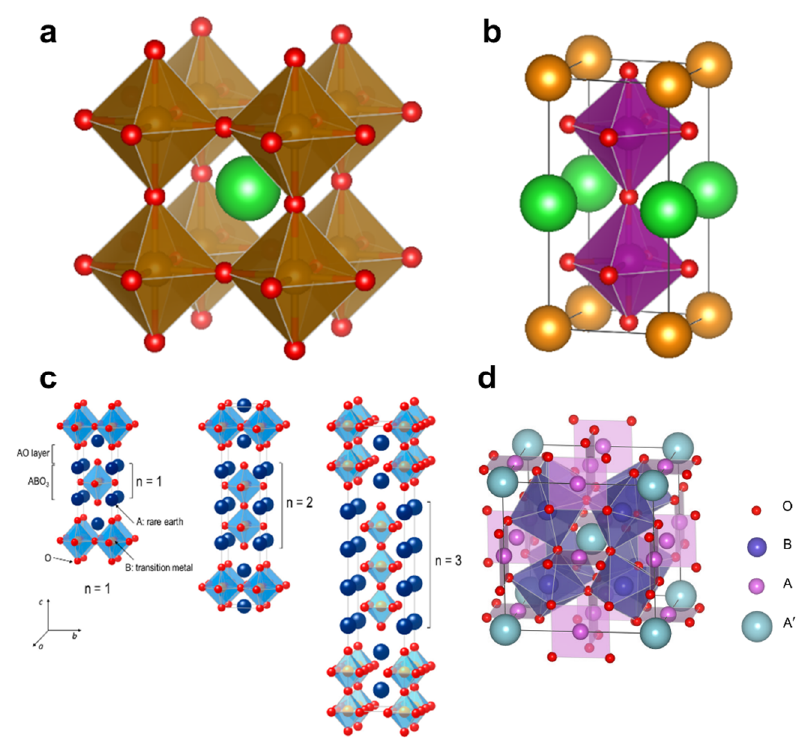
Scheme 1. Illustration of the various structures of perovskite oxides. ( a ) Primitive perovskite with an ideal cubic structure; ( b ) A-site ordered double perovskite oxide with a tetragonal structure; and ( c ) layered perovskite with a Ruddlesden–Popper structure (A n+1 B n O 3n+1, n = 1, 2, and 3); reproduced